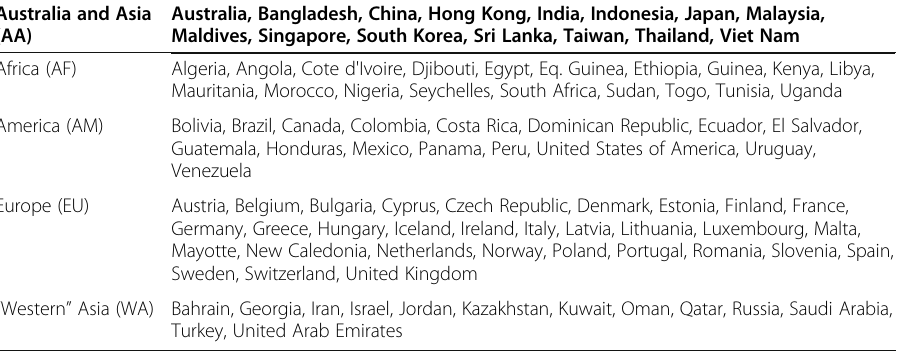
Table 6 List of countries and regions Australia and Asia